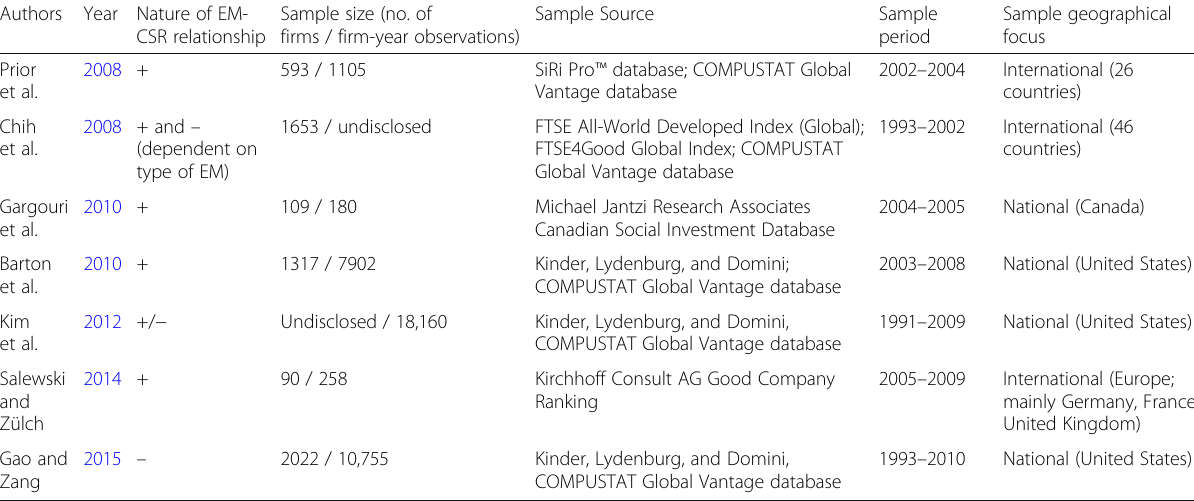
Table 1 Overview of current literature on the EM-CSR